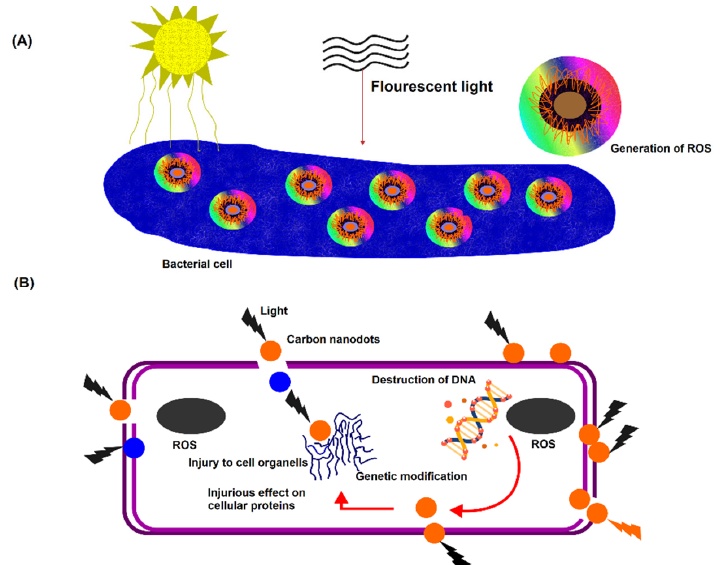
Figure 4. An illustration representing the mode of action of carbon nanodots against bacterial cells. ( A ) Adhesion of carbon nanodots to the bacterial cell surface, and the visible-light-induced ROS generation. ( B ) ROS mediated intracellular bacterial cell damage.